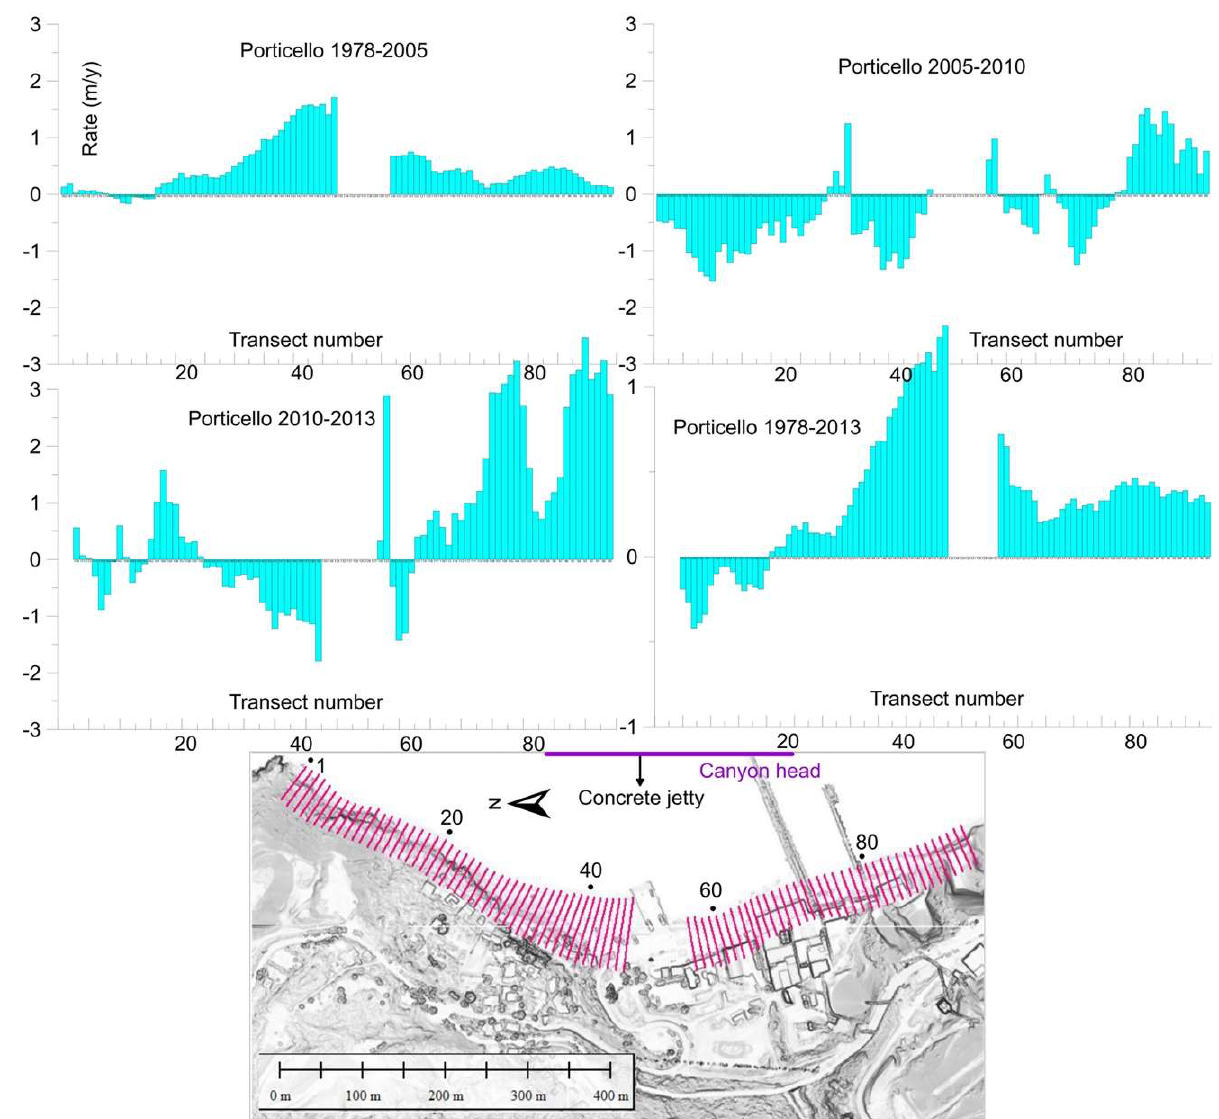
Figure A3. Rate of shoreline displacement for Porticello beach, estimated by means of DSAS along transects spaced 10 m for the different time intervals and for the overall time span of the analysis.